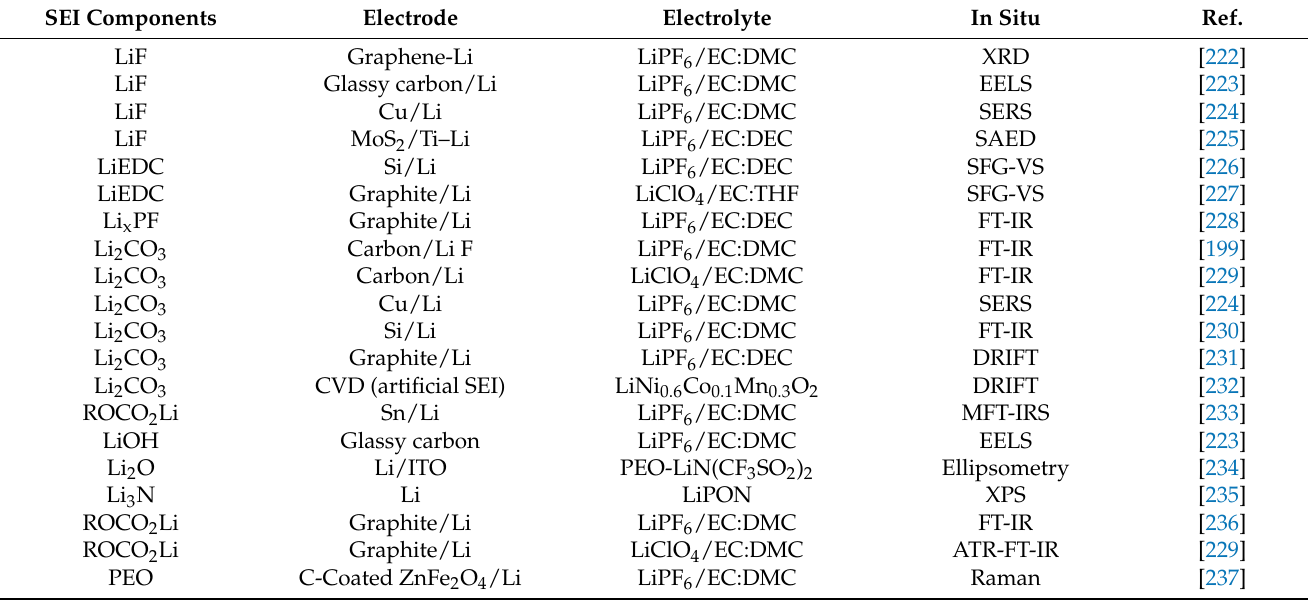
Table 4. Common in situ analytical tools for SEI